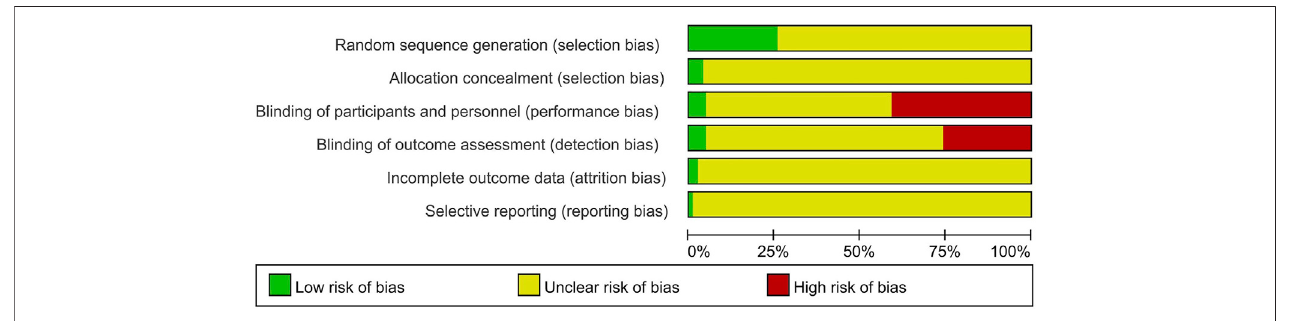
FIGURE 2 | Risk of bias of RCTs